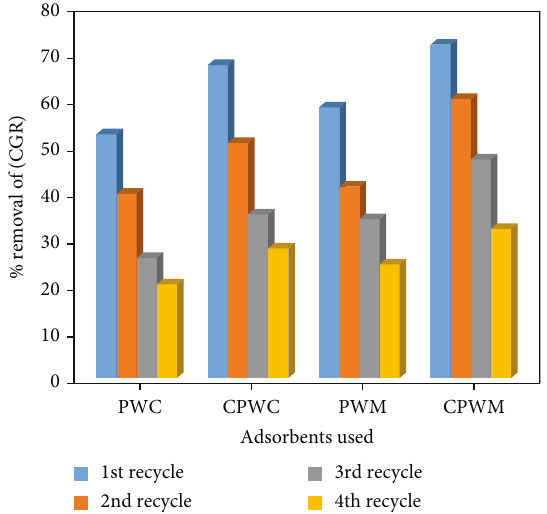
Figure 21: Study of comparative recycling of adsorbents for the degradation of